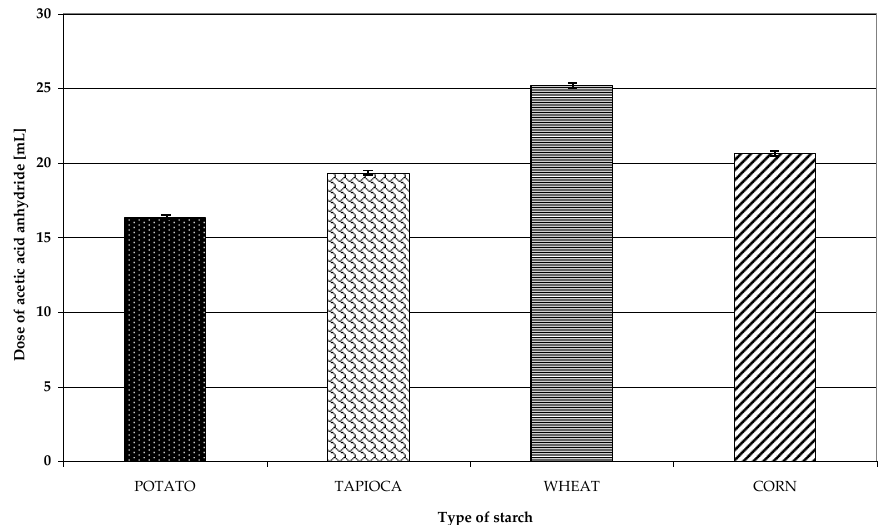
Figure 1. Dose of acetic acid anhydride needed to manufacture preparations of acetylated starch with an identical degree of substitution.